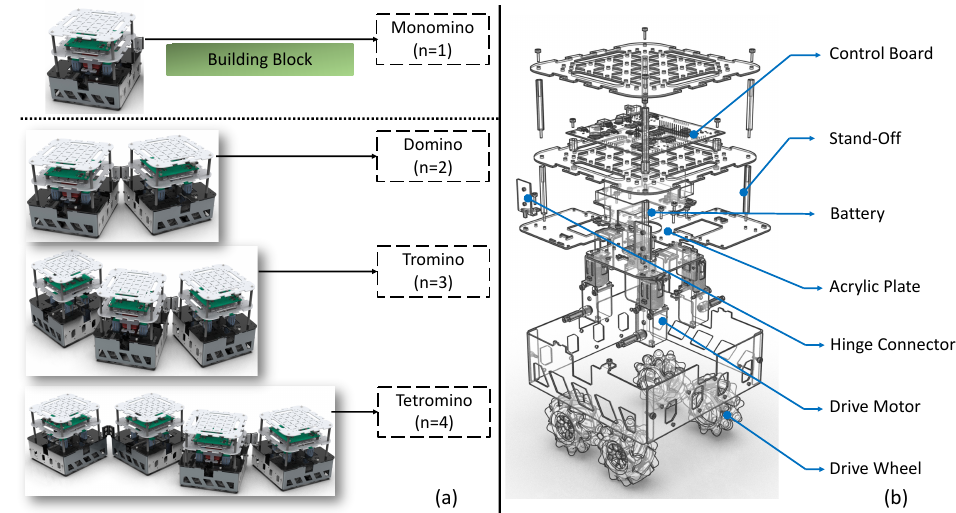
Figure 3. ( a ) Individual block (Monomino) inter-reconfigure by joining hinges and changing footprint based on angle between consecutive blocks to generate Polyominos (Domino, Tromino, Tetromino) ( b ) Isometric view of the single block with the components details